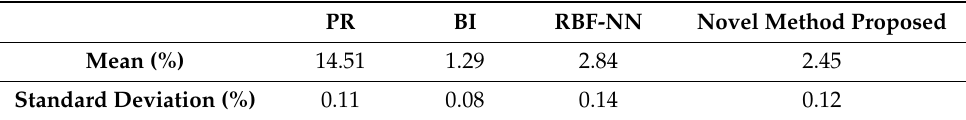
Figure 10. Comparison of results of 100 5-fold CV tests. ( a ) Polynomial Regression; ( b ) Bilinear Interpolation method; ( c ) Radial Basis Kernel Function Neural Network. Table 5. Results of 5-fold CV of 100 random tests of four methods.